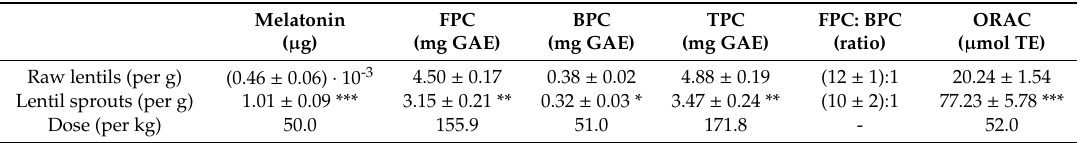
Table 2. Melatonin content, free (FPC), bound (BPC), and total phenolic compounds (TPC), FPC: BPC ratio, and in vitro antioxidant capacity measured by the ORAC method in raw lentil and lentil sprouts and the equivalence of the dose of lentil sprouts given to